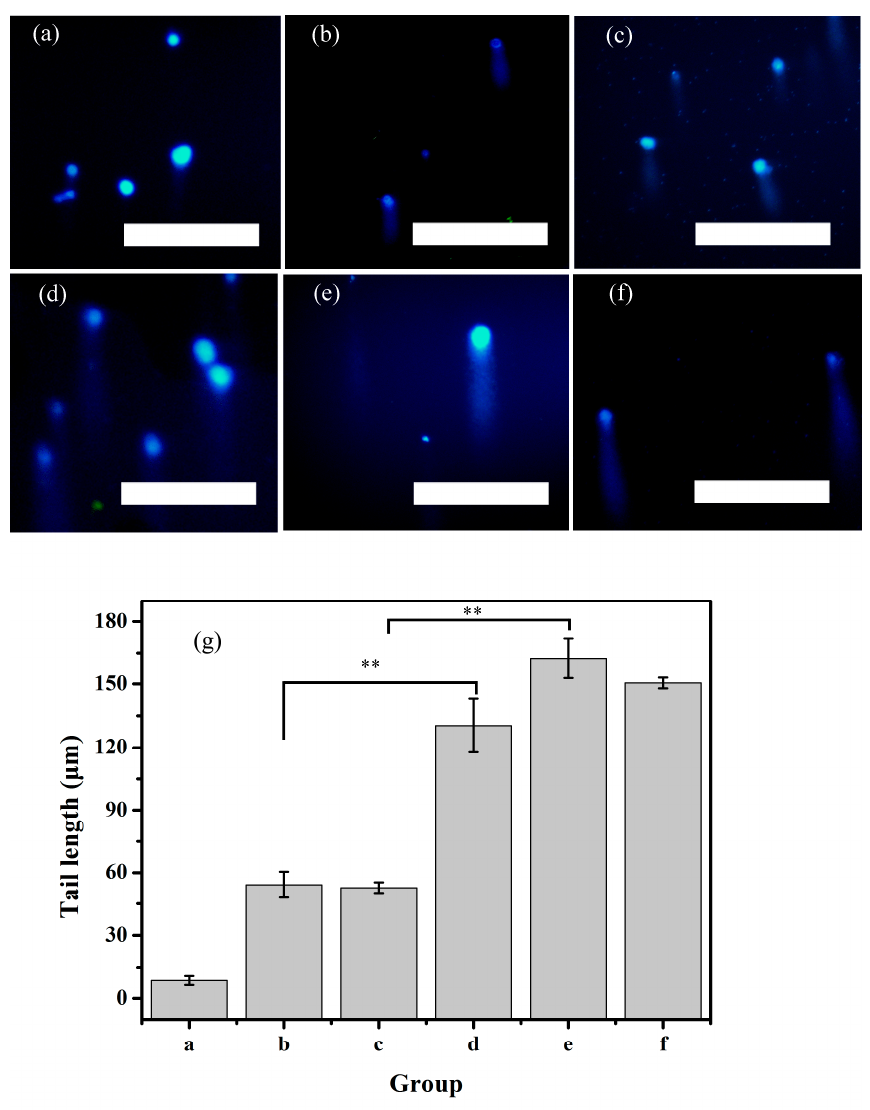
Figure 7. Comet assay. ( a ) Control; ( b ) 600 mg/L 500 nm PS-MPs; ( c ) 600 mg/L 500 nm PS-TC MPs; ( d ) 600 mg/L 60 nm PS-NPs; ( e ) 600 mg/L 60 nm PS-TC NPs; ( f ) 20 mg/L TC; ( g ) The tail length of Figure 7a–f; (scale: 250 µ m; **: p < 0.01).